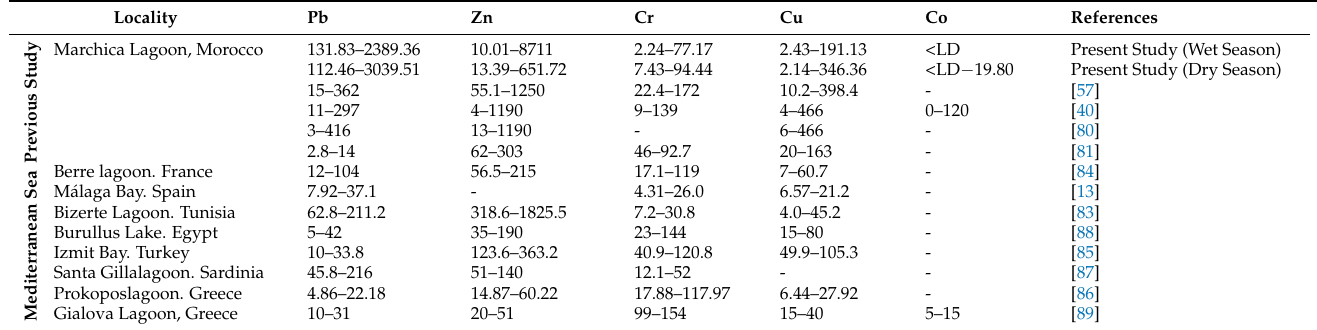
Table 6. Comparison of the minimum and maximum trace elements (mg/kg) in sediment of Marchica Lagoon with previous studies and with others lagoons in the Mediterranean